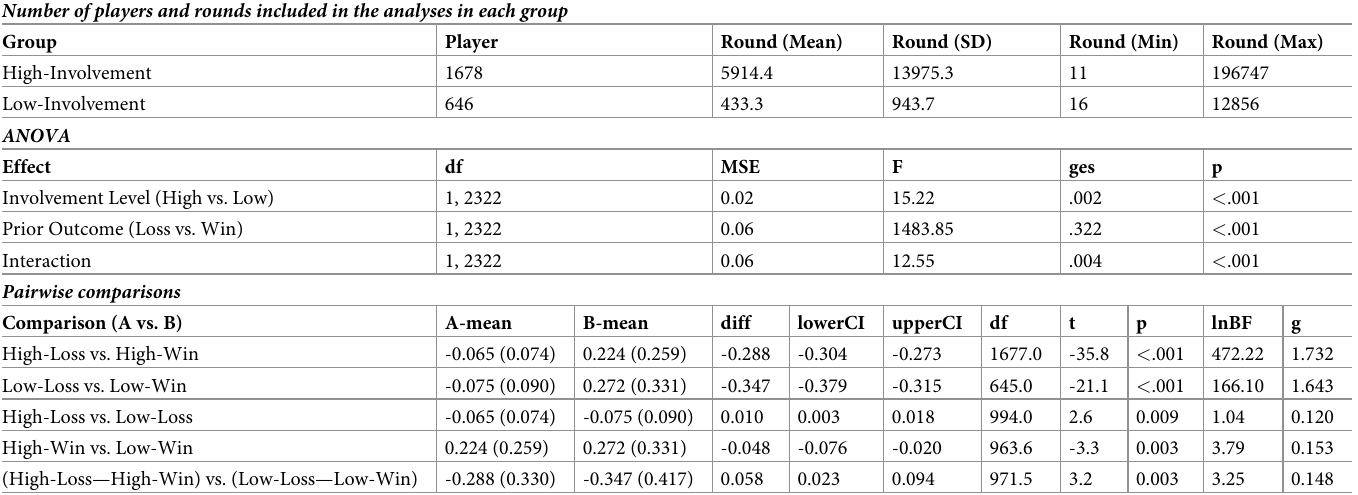
Table 6. Statistical analyses on speed of